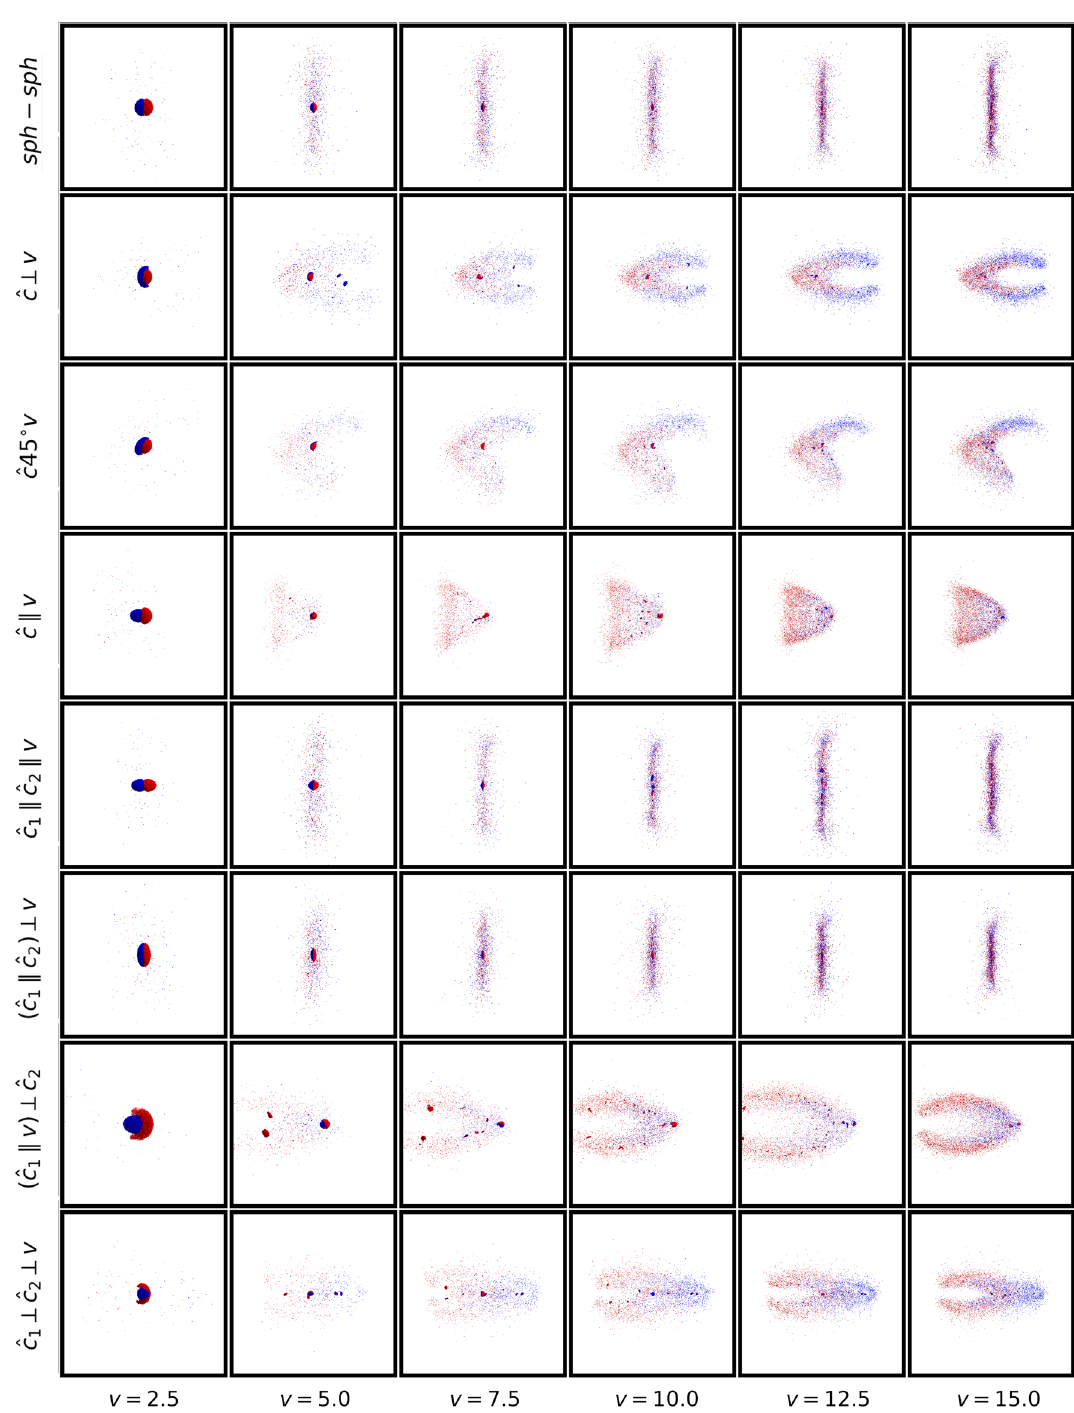
Figure 2. Tableau of the final state after the collision of two aggregates colliding with velocity v (in units of m/s) and the collision geometries, cf. Table 1. Size of the space plotted in the subpanels changes with collision velocity. For the sake of a clear visualization of the monomers and small fragments, the grain size is appropriately scaled with the subpanel boxes. Grains are colored according to their initial aggregate affiliation. Figure created using POV-Ray 23